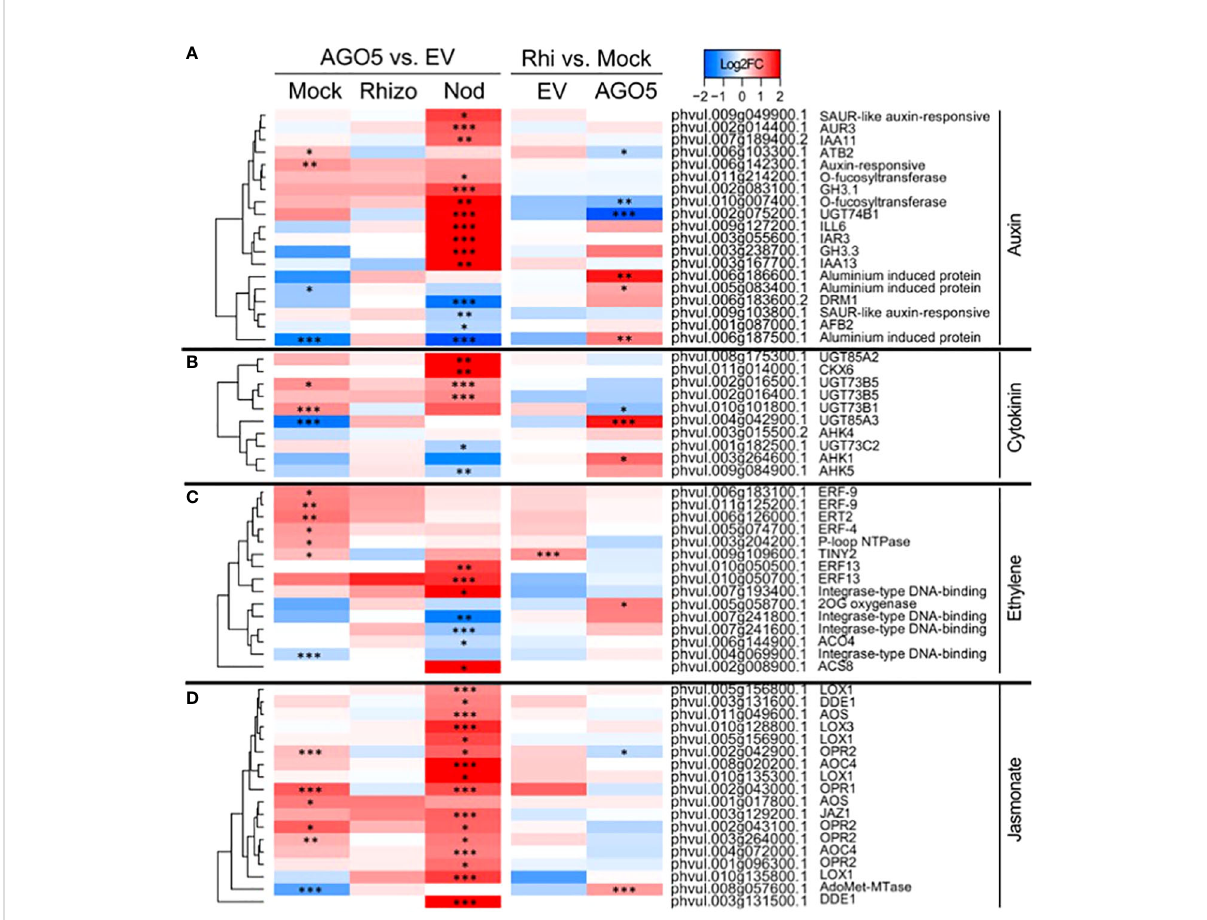
FIGURE 4 PvAGO5 modulates the expression of genes participating in the biosynthesis and signaling of phytohormones. Heatmaps showing Log2 fold-change of gene transcripts involved in the biosynthesis and signaling of auxins (A) , cytokinins (B) , ethylene (C) , and jasmonate (D) . Fold-changes are false- colored. Genes showing higher and lower expression difference are shown in different shades of red and blue, respectively. Labels at the top of the heatmap located on the left side indicate: Mock= uninoculated transgenic roots; Rhizo= rhizobia-inoculated transgenic roots, and Nod = mature nodules. In both cases the comparison between PvAGO5- RNAi vs Empty Vector is shown. Labels at the top of the heatmap located on the right side indicate: EV= transgenic roots expressing the empty vector (control), and AGO5: transgenic roots expressing the PvAGO5- RNAi construct. In both cases the comparison of rhizobia-inoculated roots vs mock-inoculated roots is shown. Asterisks indicate different levels of statistical signi fi cance of the comparisons (*: adjusted P-value<0.05; **= adjusted P-value<0.01; ***= adjusted P-value<0.001). Genes with no asterisk are not signi fi cantly differentially expressed. Dendrogram (left) represents the transcript clustering based on expression pro fi